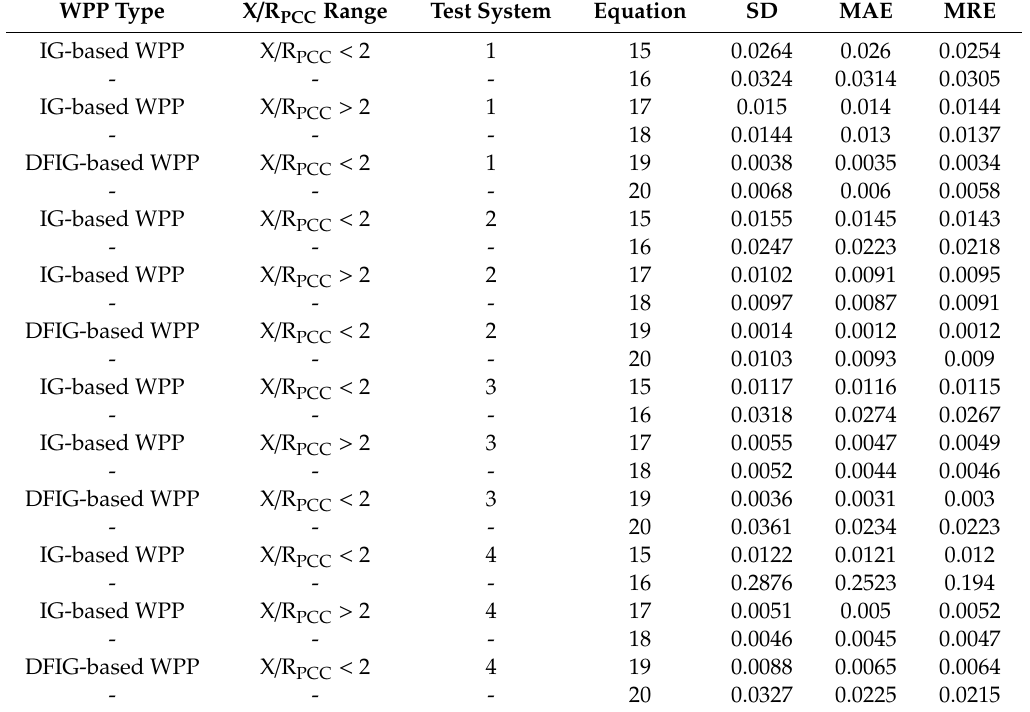
Error between the reference V PCC -X / R PCC graphs and the graphs plotted by the alternative